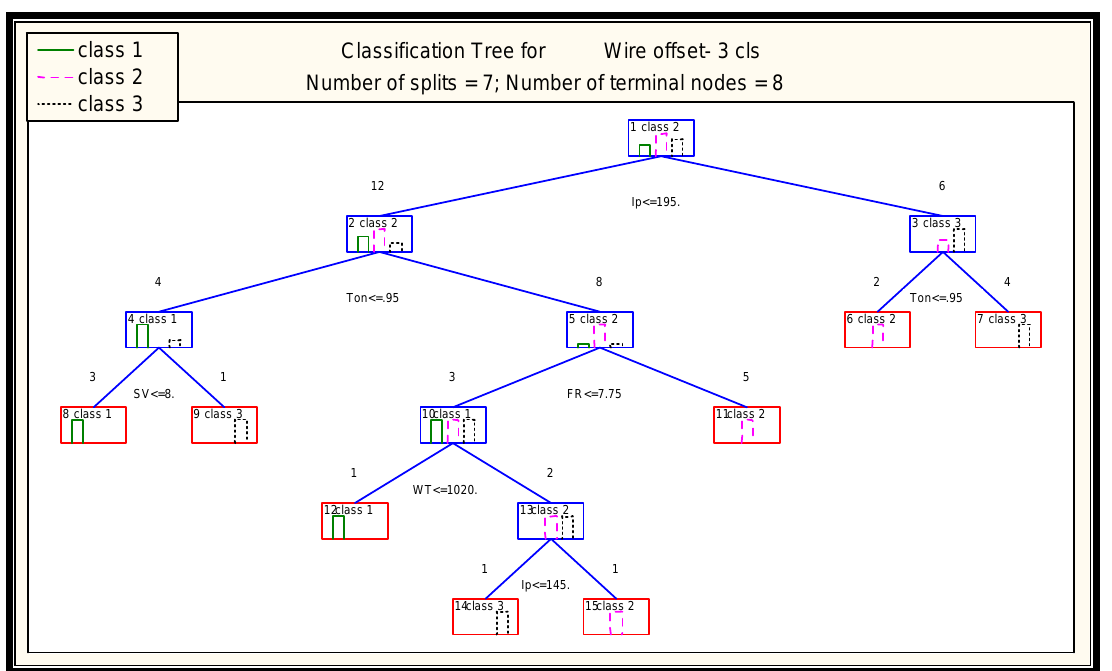
Fig. 10. Decision tree for wire offset (three